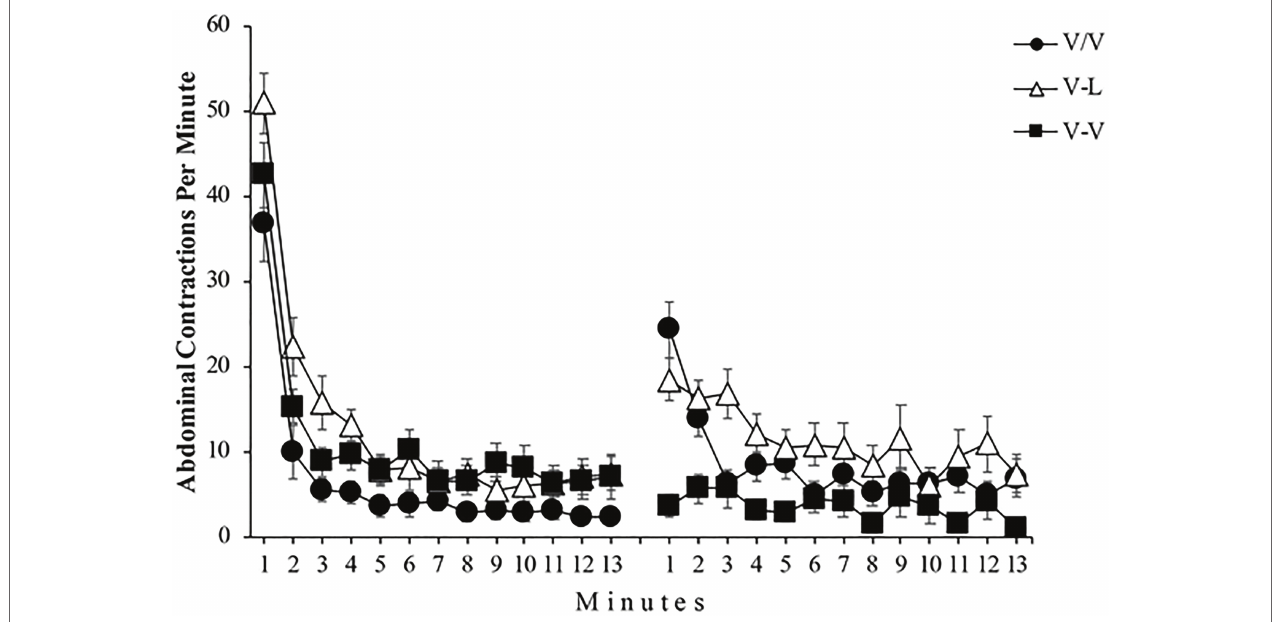
FIGURE 4 | Mean abdominal contractions during the 13 minutes of Phase 1 (left panel) and the 13 minutes of Phase 2 (right panel) of Experiment 2. Error bars denote standard errors of the